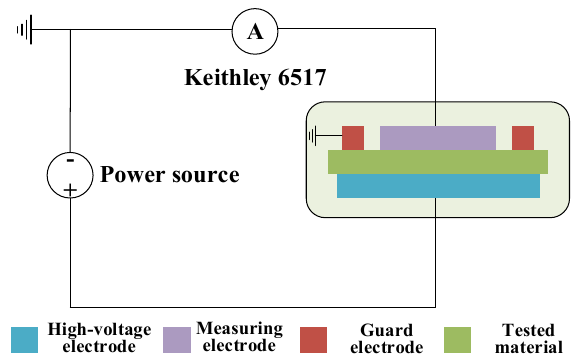
Figure 1. DC conductivity measurement